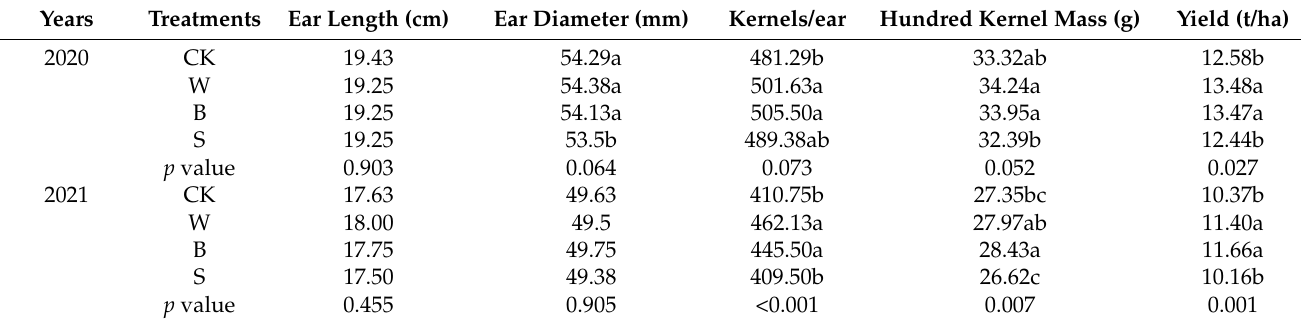
Table 2. Yield and its components among treatments for the two years. Notes: Data are given as means with standard deviations in